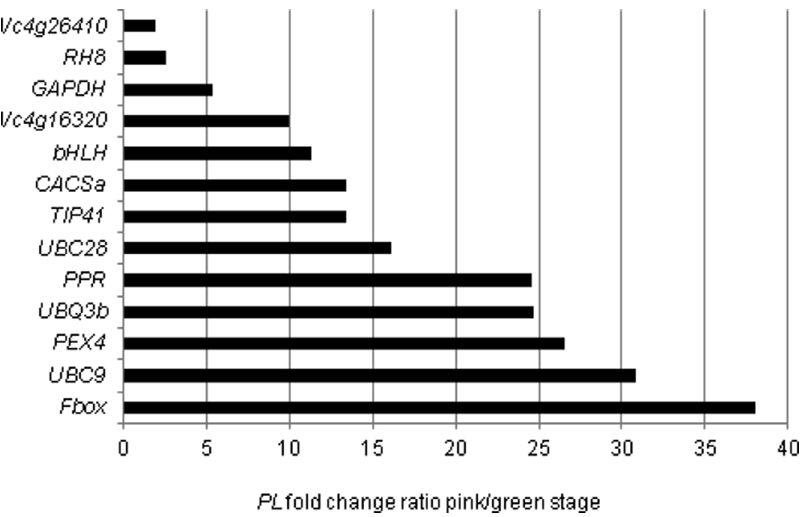
Figure 4. Normalization of pectate lyase ( PL ) mRNA expression in blueberry at green and pink fruit developmental stages using 13 different reference genes. The PL mRNA ratio in pink fruit: green fruit (x-axis) was calculated using the 13 different reference genes shown on the y-axis. The ratio was calculated taking the gene specific amplification efficiencies into account (target gene and reference gene) according to the quantification model proposed by Pfaffl [15].